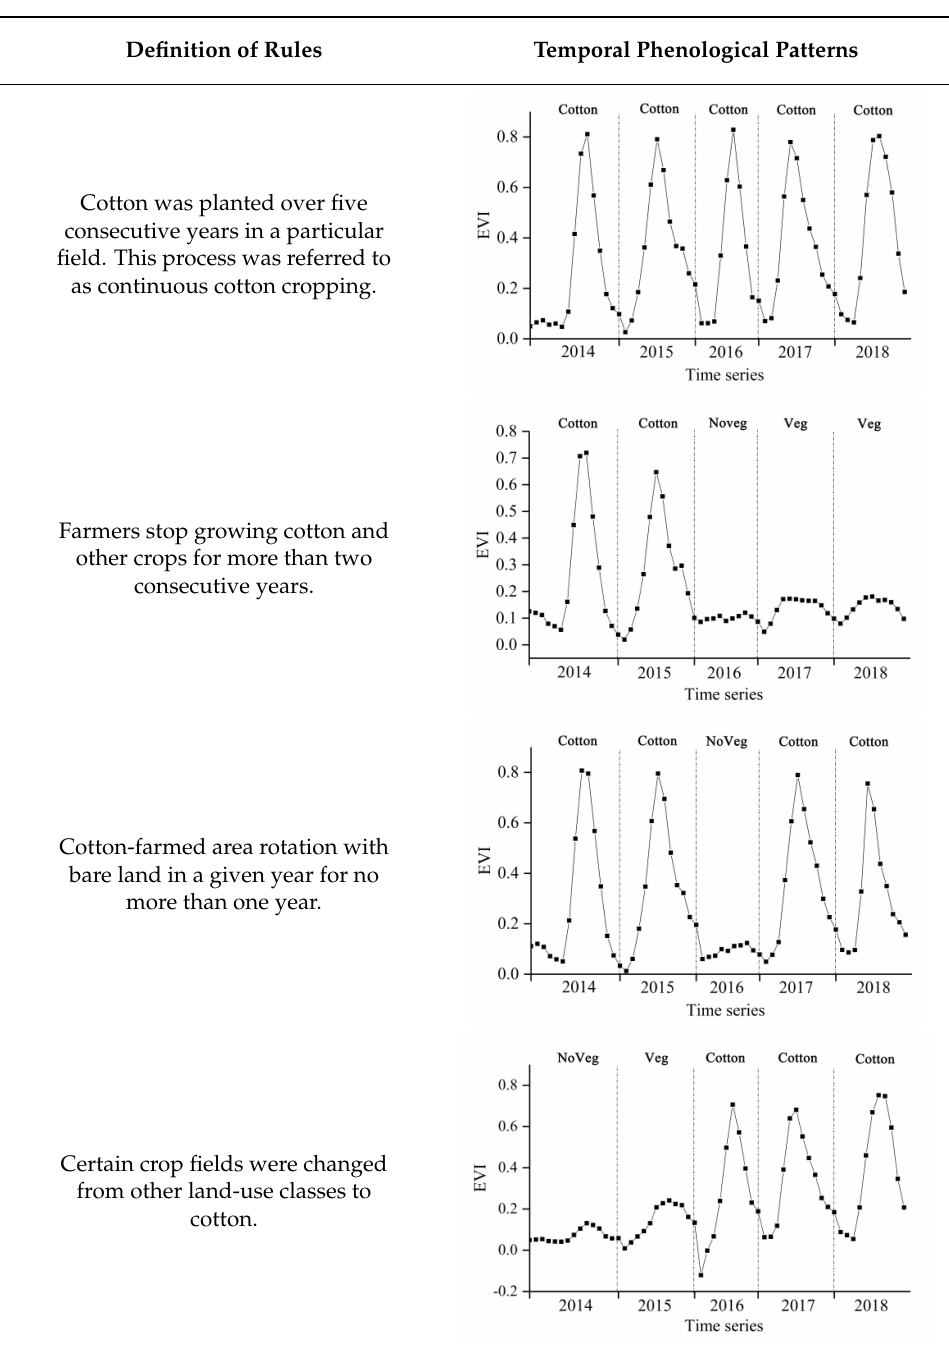
Table 1. Rules of multi-year cotton-farming pattern